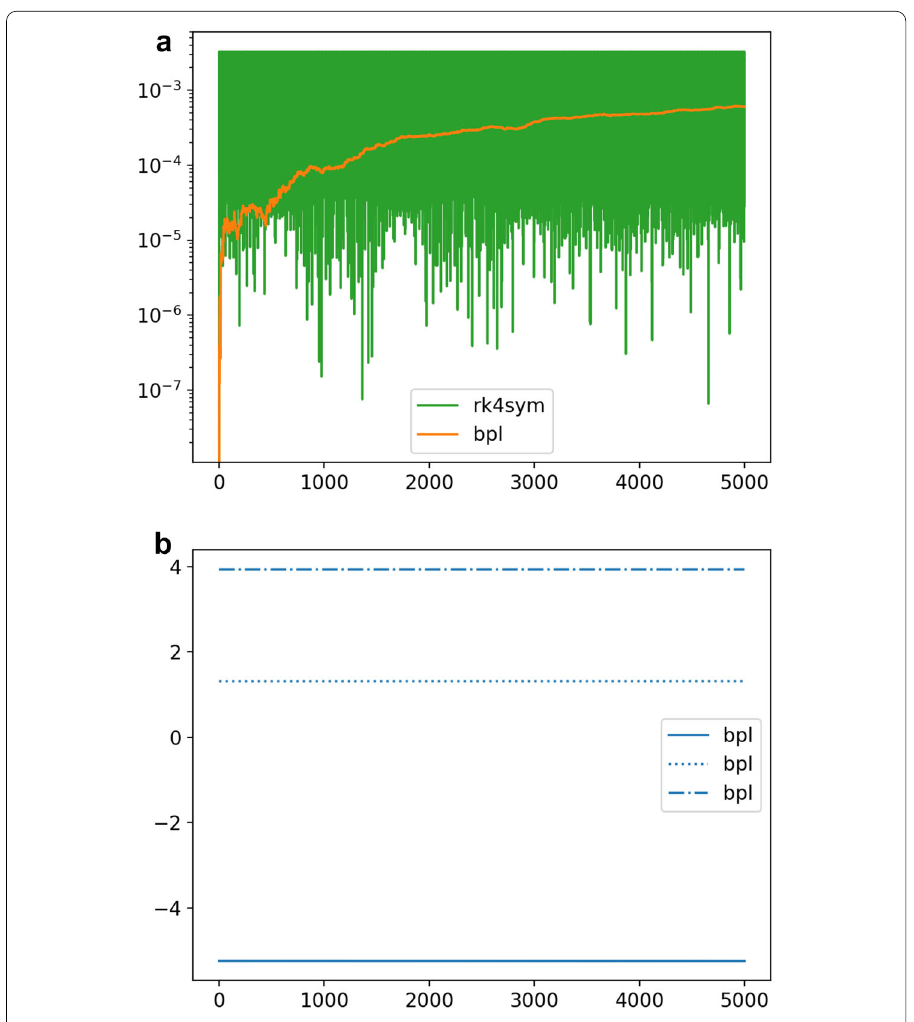
Fig. 11 Toda lattice with δ t (cid:7) 0 . 0983. a Local errors on H . b Eigenvalues computed with BPL